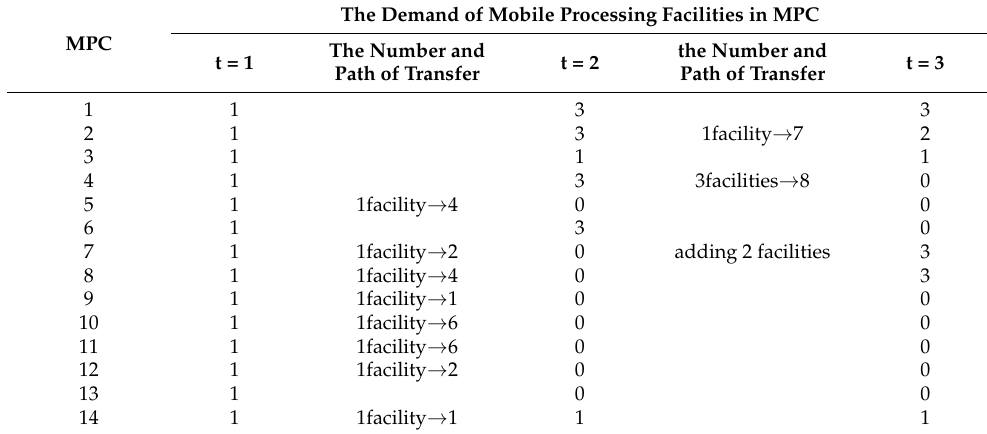
Table 8. Mobile processing facility transfer scheme in different outbreak situations.